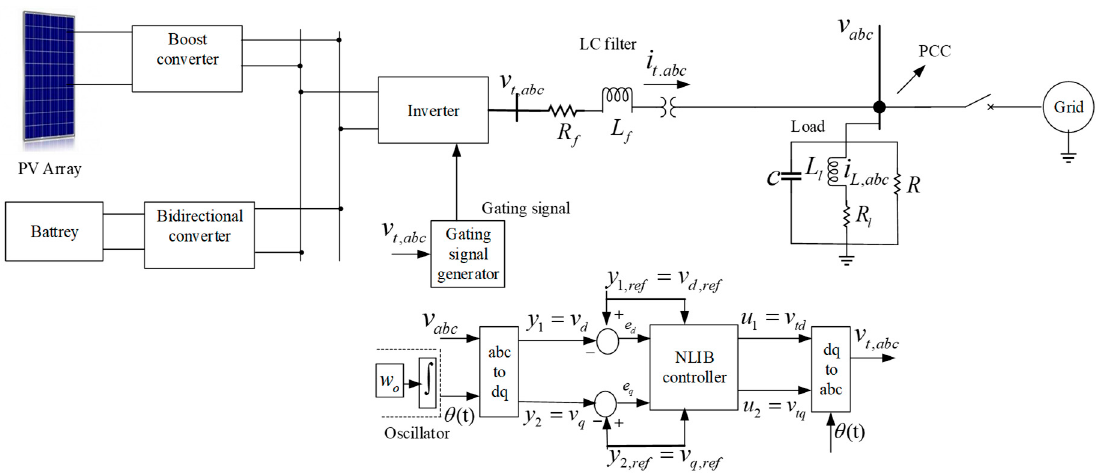
Figure 1. Block diagram of islanded microgrid inverter.